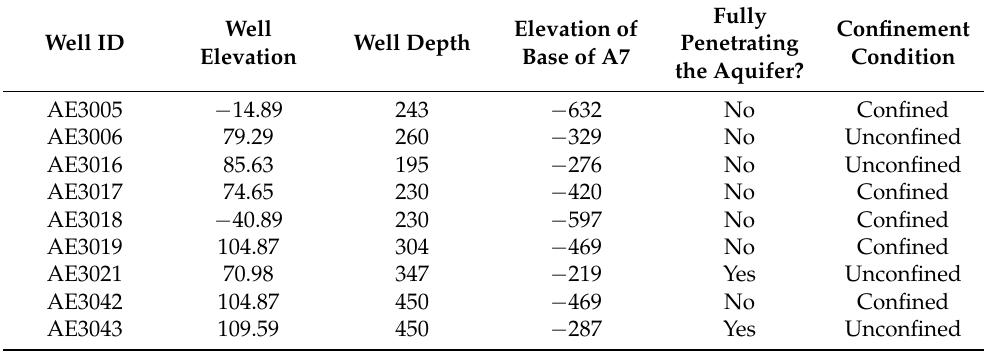
Table 3. Confinement condition and penetrating extent test for the Wadi Al Arab wells with no lithological